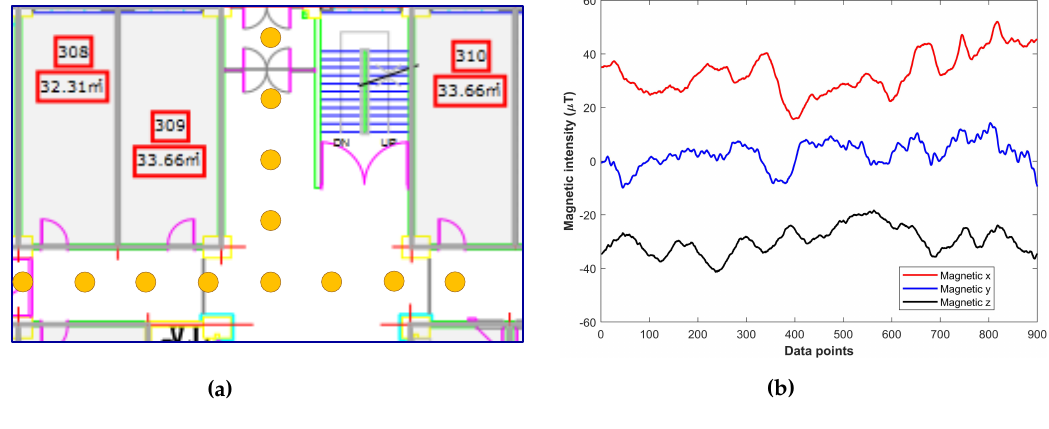
Figure 2. ( a ) data collection at indexed locations; ( b ) interpolated magnetic data after data